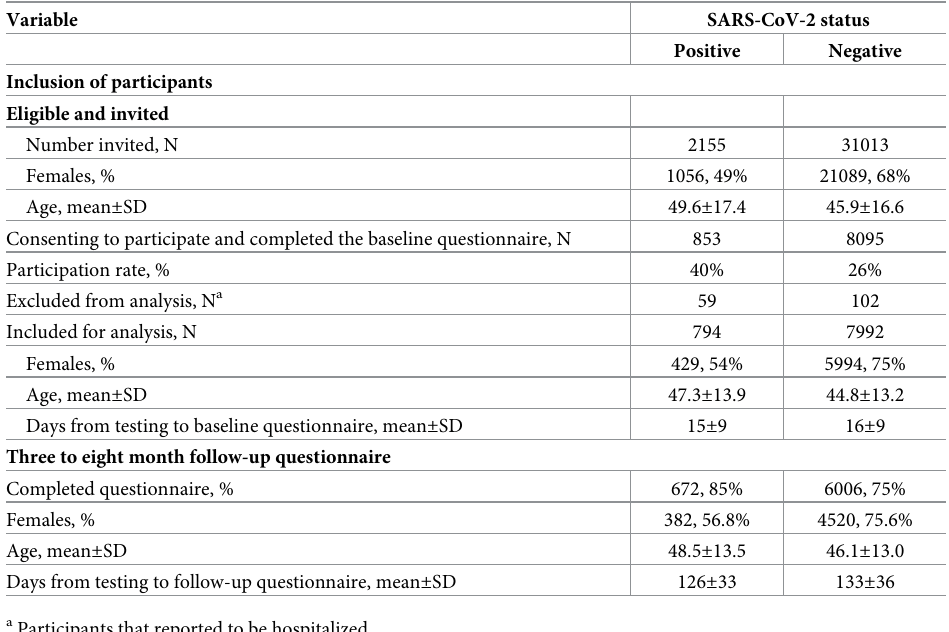
Table 1. Inclusion and